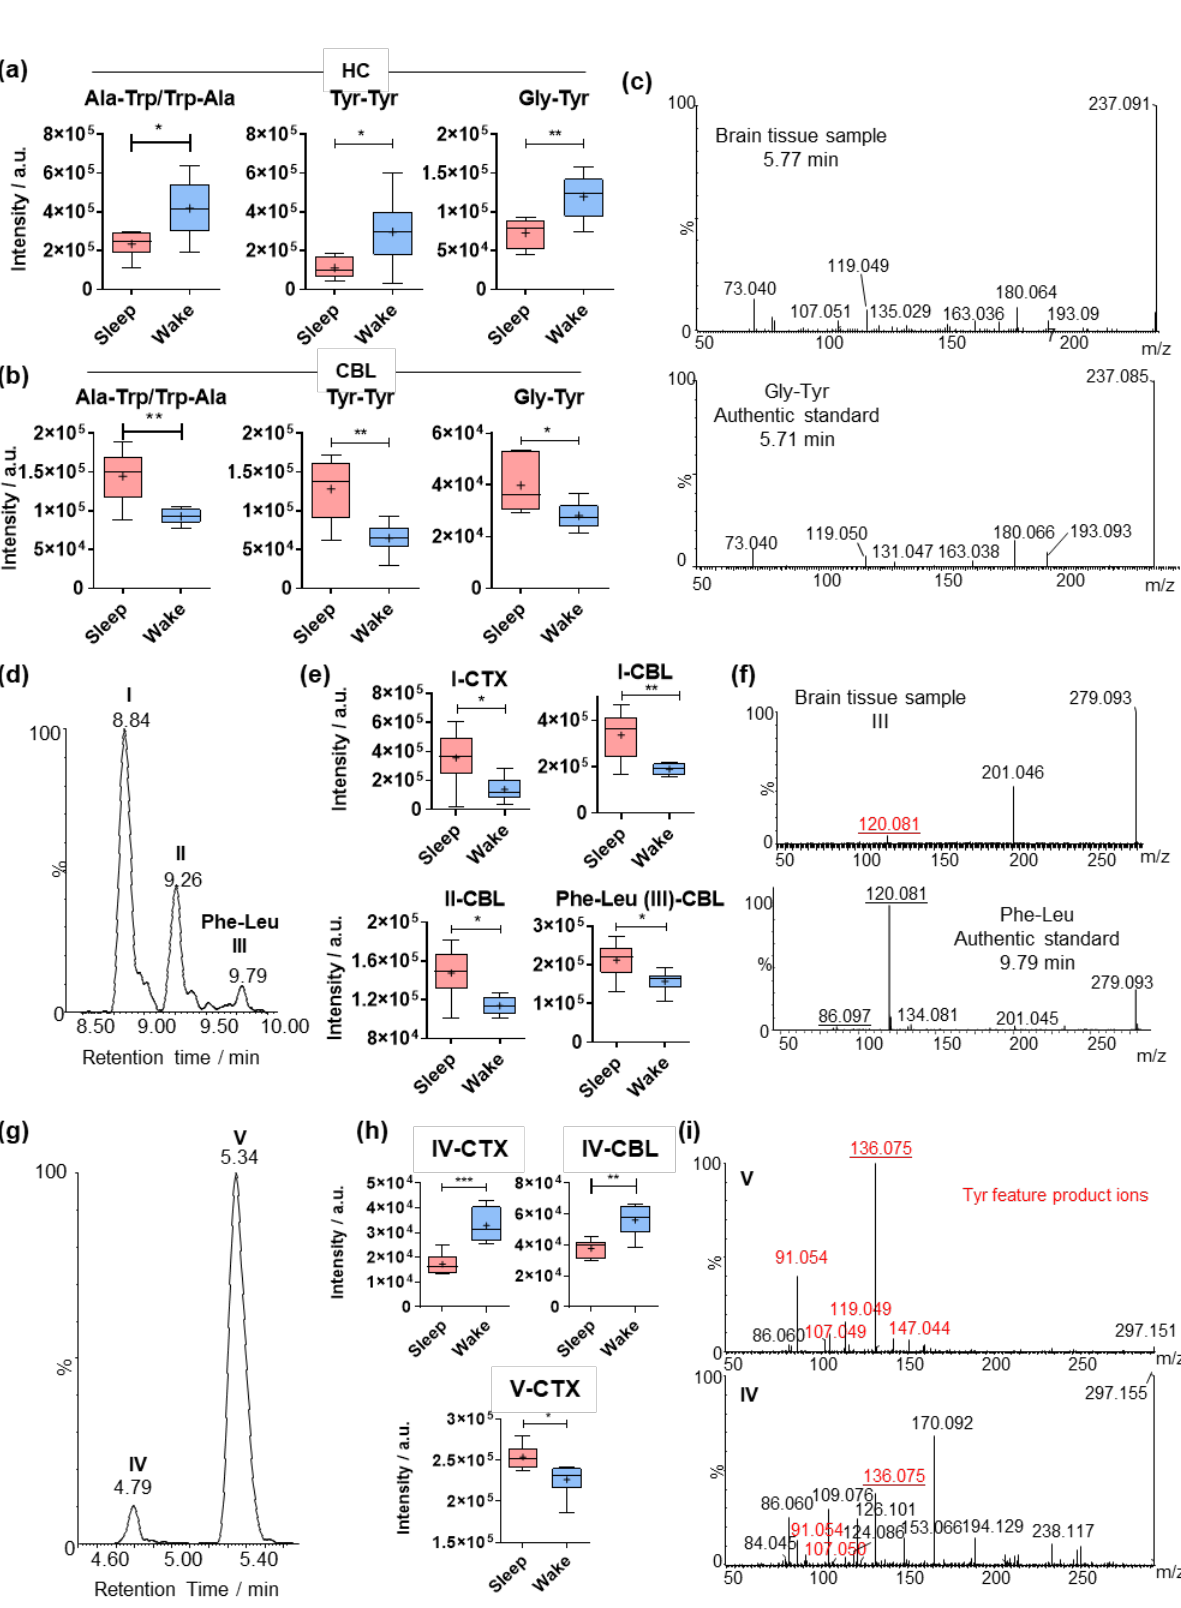
Figure 4. Comparison of significantly altered dipeptides in the investigated brain regions. ( a ) Mass spectrometric intensities of representative tyrosine (Tyr)-containing dipeptides in the hippocampus (N = 6). ( e ) Structure validation of glycyl-tyrosine (Gly-Tyr) by comparison of tandem spectra collected from pooled brain sample and an authentic standard. Extracted ion chromatogram of m / z 279.170 in positive ionization mode. The 3 different chromatographic peaks at 8.84, 9.26 and 9.79